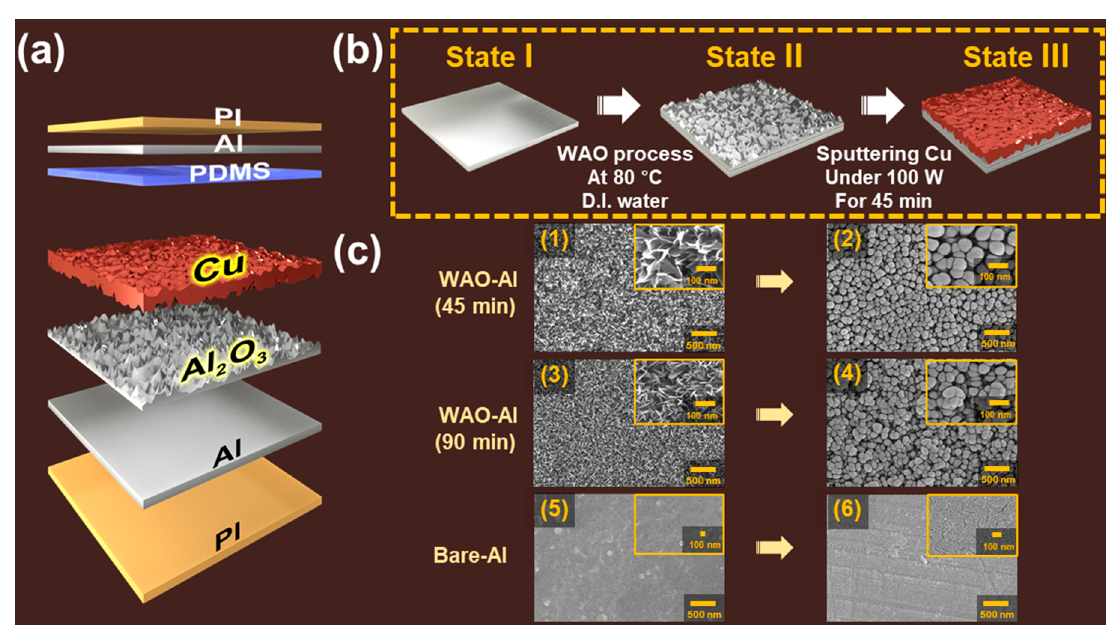
Figure 1. ( a ) Schematic illustration of the double-layered electrode triboelectric nanogenerator (DE-TENG); ( b ) the fabrication process of the DE-TENG (water-assisted oxidation process and additional deposition layer with sputtering) and ( c ) the field emission scanning electron microscope (FE-SEM) images (WAO-Al treated for ( c1 ) 45 min and ( c3 ) 90 min, Cu-sputtered onto the layer of WAO-Al for ( c2 ) 45 min and ( c4 ) 90 min, ( c5 ) Bare-Al and ( c6 ) Cu sputtered onto the Bare-Al.)